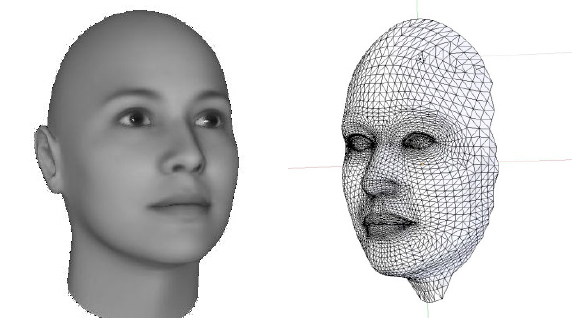
Figure 2. Morphable face model